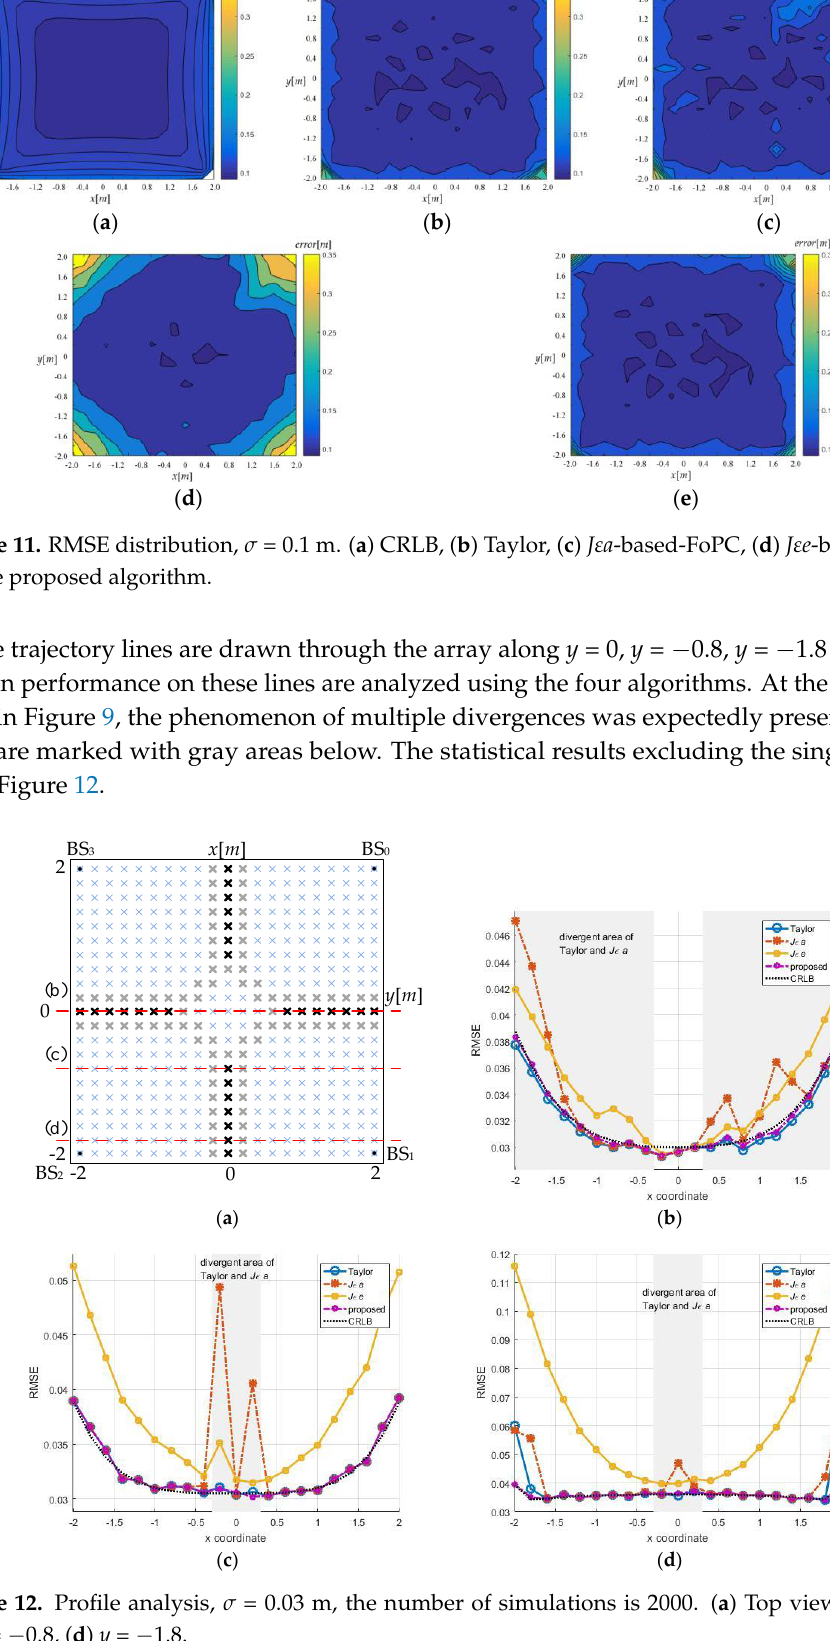
( c ) y = −0.8, ( d ) y = −1.8. ( c ) y = − 0.8, ( d ) y = −